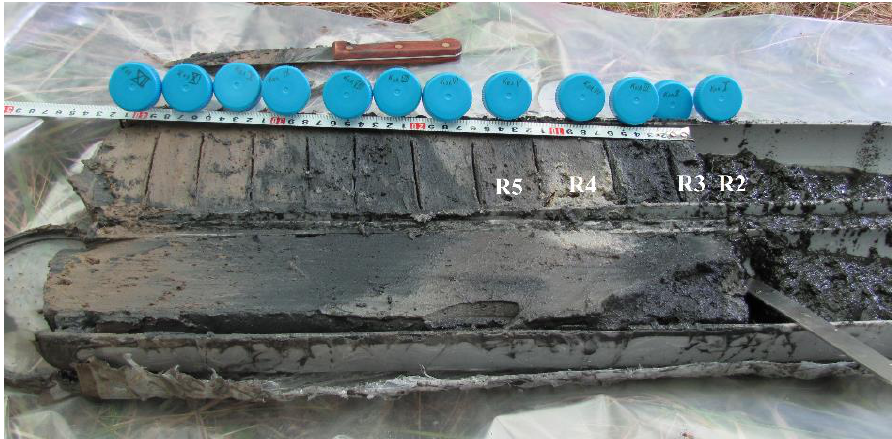
Figure 2. The column (core sample) of bottom sediments from Lake Solenoe (layers used for DNA isolation and metagenomic sequencing are marked in white).